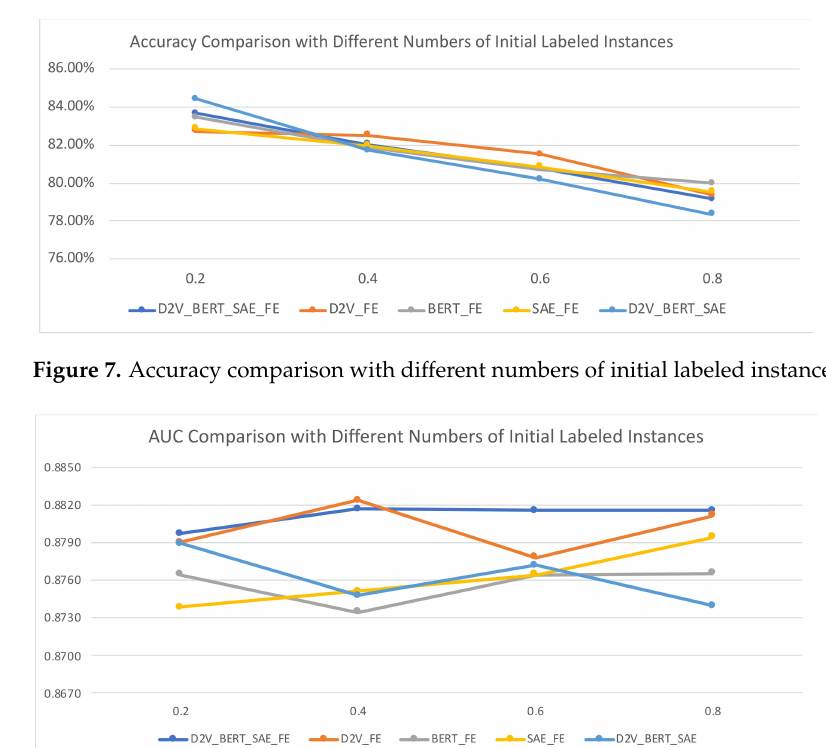
Figure 6. AUC comparison of different selection strategies.